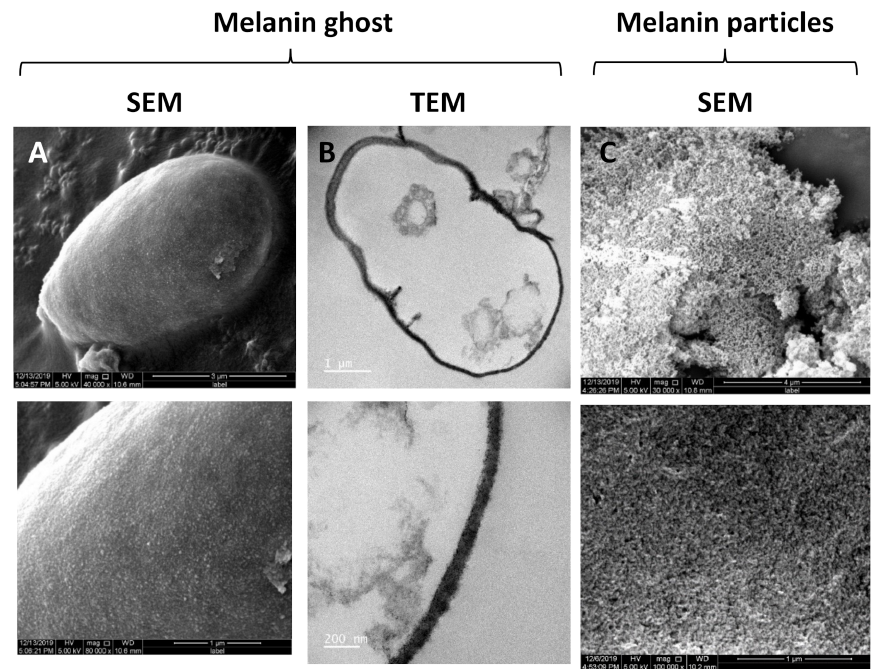
Figure 2. ( A ) FESEM and ( B ) TEM imaging melanin ghosts and ( C ) SEM imaging melanin